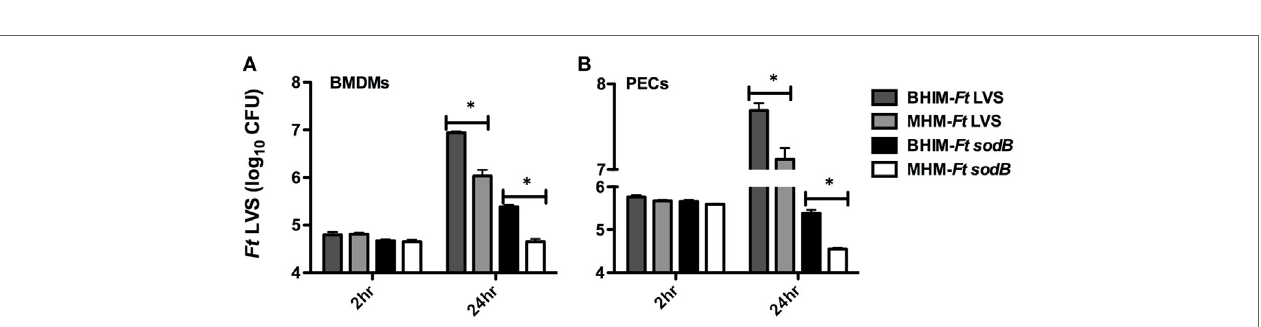
FigUre 2 | Differential intracellular growth kinetics of brain-heart infusion medium (BHIM)- Francisella tularensis ( Ft ) versus Mueller-Hinton Medium (MHM)- Ft. BMDMs (a) or resident peritoneal macrophages (B) from naive C57BL/6 male or female mice were incubated at an multiplicity of infection of 50 for 2 h with Ft (LVS or sodB ) grown in either BHIM or MHM. After Ft infection, intracellular replication was quantified by plating and counting CFU at 2 and 24 h post-infection. Data show mean values and SEM from three independent experiments. * p < 0.05.